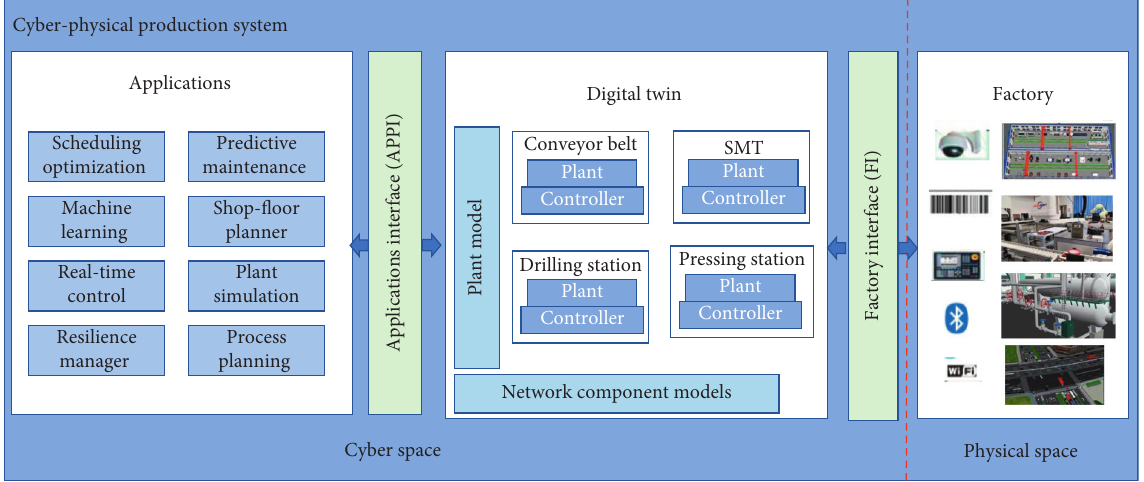
Figure 1: Digital twin in